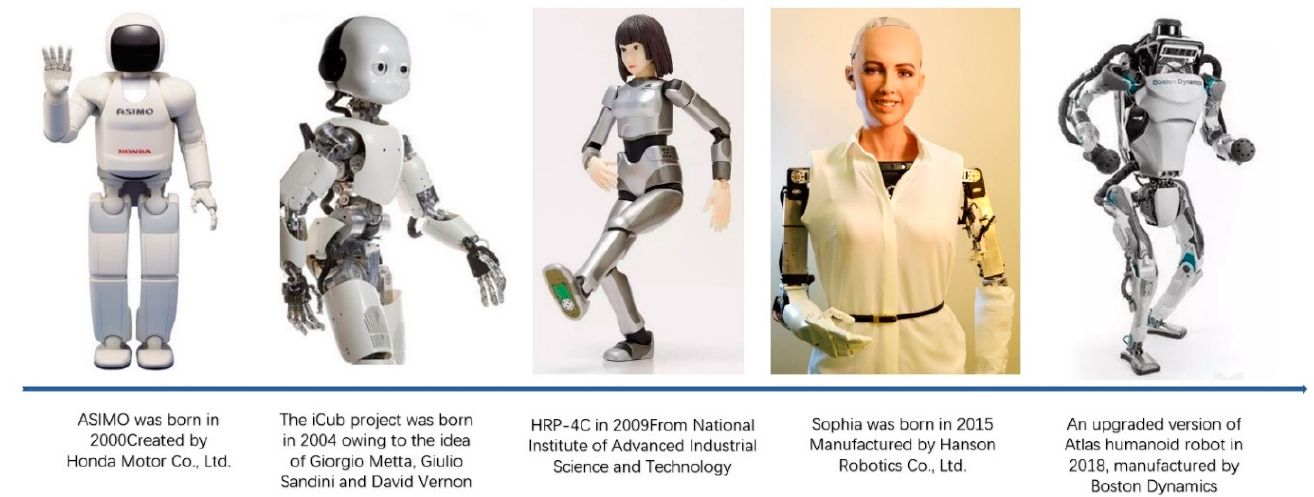
Figure 6. Robots that have bionic vision. Copyright: Robot licensed by Maximalfocus US-L.